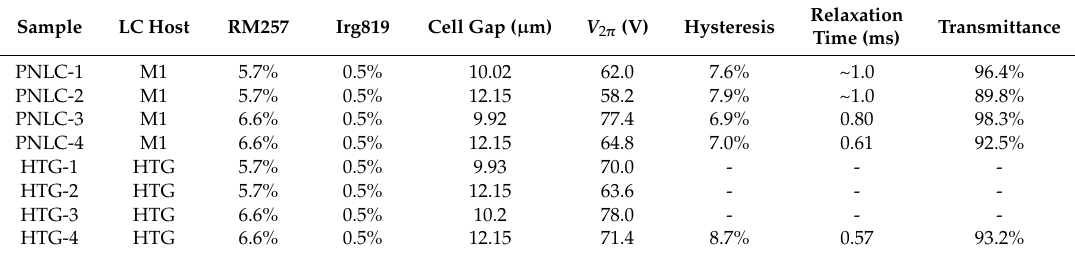
Table 3. Compositions and electro-optic performance of eight polymer-network liquid crystal (PNLC) samples with di ff erent RM257 concentrations and cell gaps. λ = 1.06 µ